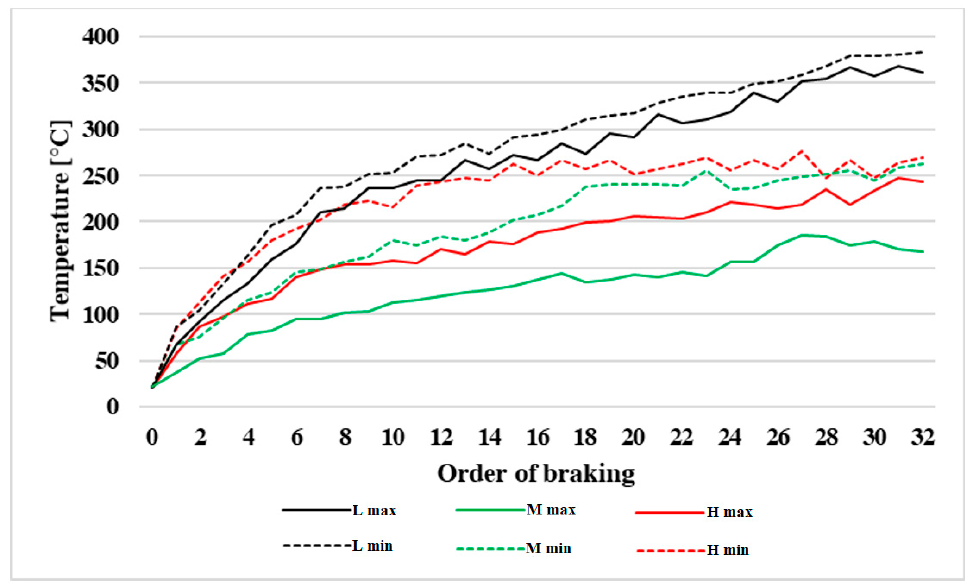
Figure 11. Brake discs’ temperature during repeated braking 32 times in a row.